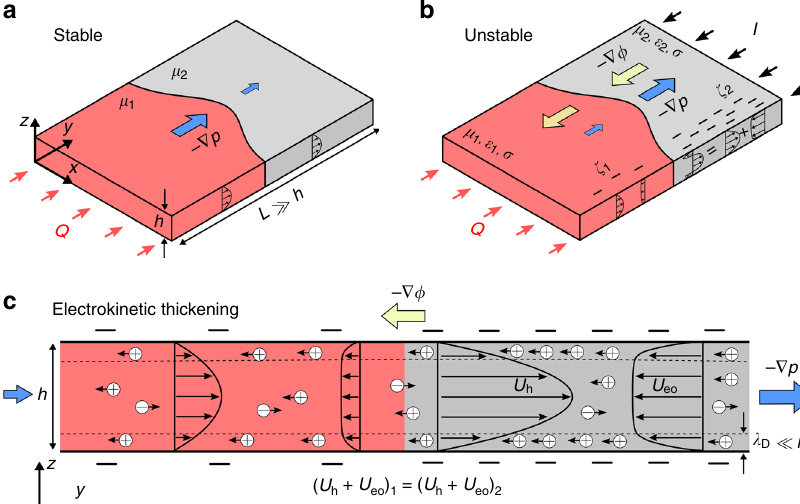
Fig. 1 Electric fi elds can alter the interfacial stability in a Hele-Shaw cell. a Hydrodynamically Stable: an interface moves in response to a pressure gradient and follows the path of least resistance. When the invading fl uid has a higher viscosity ( μ 1 > μ 2 ), the hydraulic resistance is stronger behind the interface and the motion is stable. b Becomes Unstable with External Electric Field: Applying an electric fi eld drives an additional “ electro-osmotic ” fl ow. When the electro-osmotic fl ow is in the opposite direction of hydraulic fl ow, the overall resistance is enhanced due to apparent “ electrokinetic thickening ” . If electro-osmotic fl ows are stronger ahead of the interface, electrokinetic thickening destabilizes the interface motion for suf fi ciently large electric fi elds. c Mechanism: apparent electrokinetic thickening: Glass surfaces are negatively charged in aqueous solutions due to dissociation of silanol groups. An applied electric fi eld acts on the positive ions in the EDL (thickness λ D ≪ h ) and drives an electro-osmotic fl ow ( U eo ) in the opposite direction as hydraulic fl ow ( U fl ow rate in each phase, pressure gradients must adjust to compensate for the electro-osmotic fl ows, causing an h ). To maintain the same total apparent enhancement of the viscosity which we refer to as apparent “ electrokinetic thickening ” . Conversely, apparent “ electrokinetic thinning ” is caused if the electro-osmotic fl ows are in the same direction as hydraulic fl